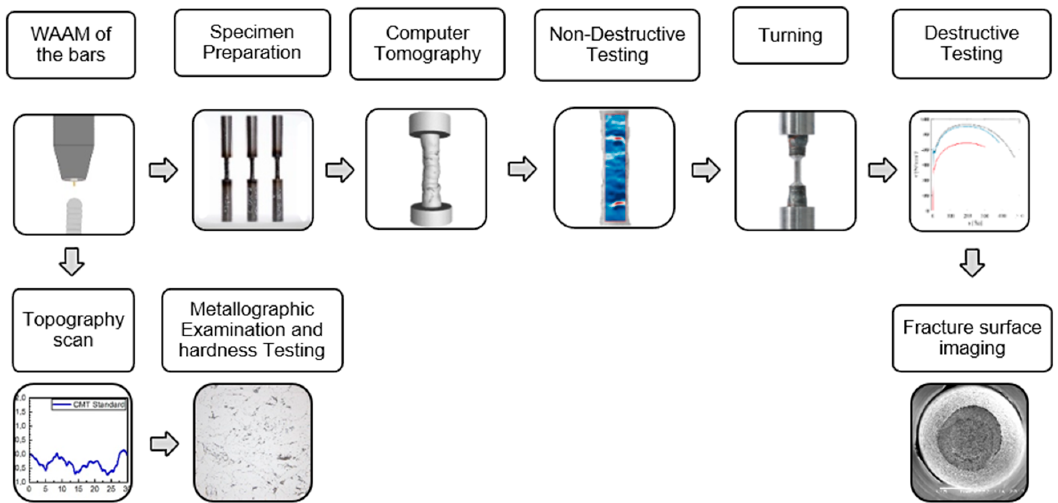
Figure 5. Advanced testing strategy for the identification of strain fields and material parameters.